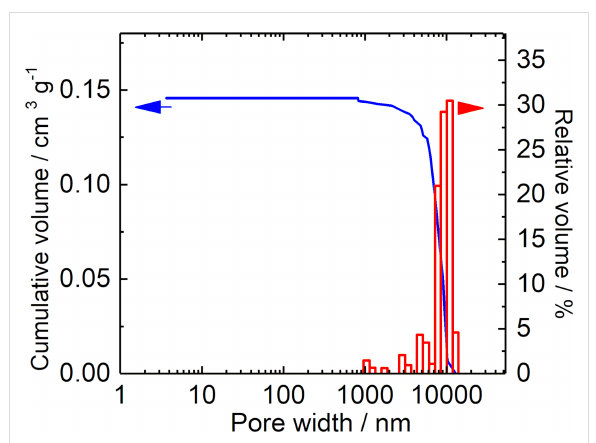
Figure 5: Hg intrusion data of the as-synthesized Na,K-ETS-10 materi-